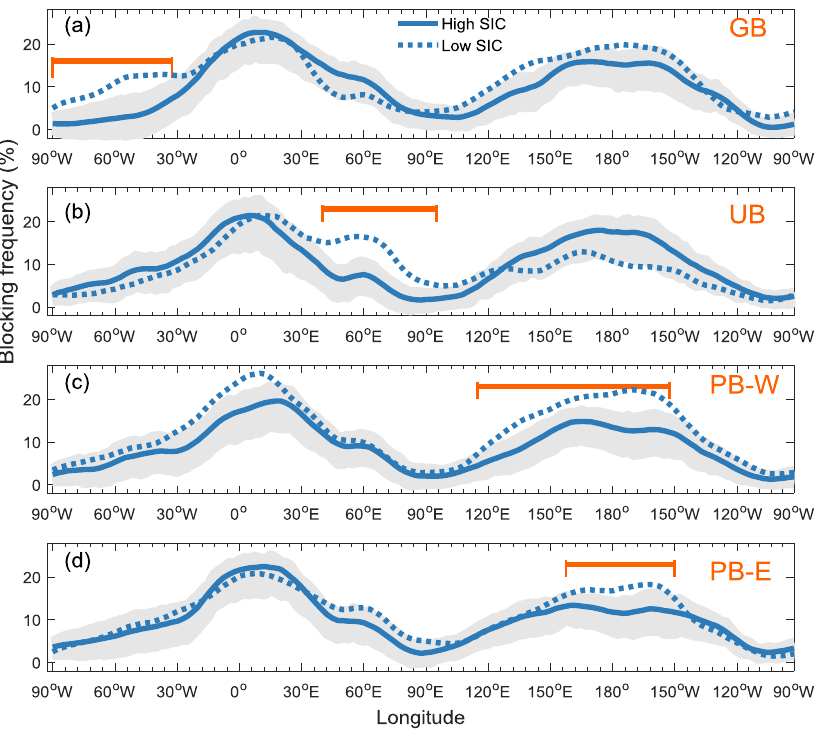
Figure 5. Composite of the frequency percentage of blocking as a function of longitude for high and low SIC in regions ( a ) Baffin Bay, ( b ) Barents-Kara Seas, ( c ) Okhotsk Sea and ( d ) Bering Sea. Solid (dashed) lines represent winters with SIC higher (lower) than 0.5 (−0.5) standard deviation during 1979–2016. GB, UB and PB-W and PB-E represent Greenland blocking, Ural blocking, Western Pacific blocking and Eastern Pacific blocking, respectively. Orange lines mark the regions with a significant difference for blocking frequency between high and low SIC winters. Dashed lines outside the gray shading indicate that the blocking frequency differences in this area between high and low SIC winters are statistically significant at the 95% confidence level in a Monte Carlo test.